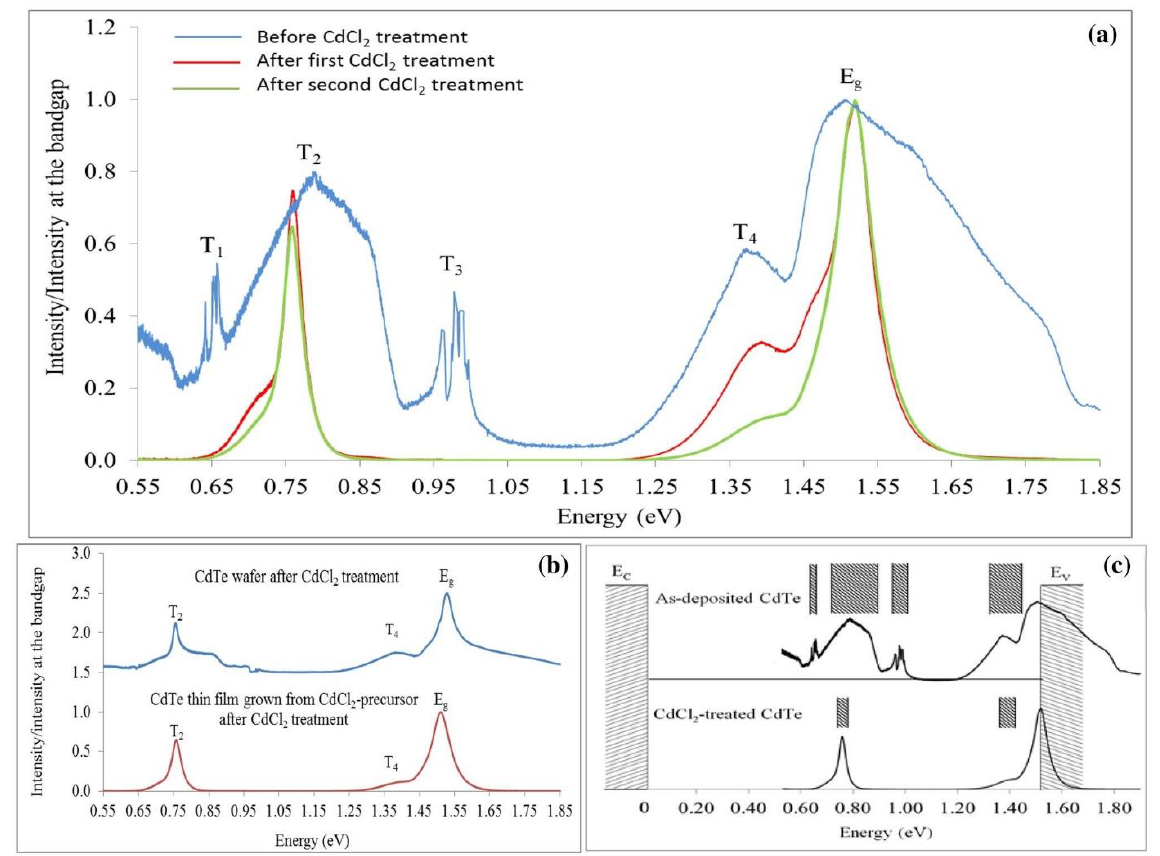
Figure 5. ( a ) PL spectra of as-deposited CdTe layers, grown from Cd-chloride precursor and the effects of subsequent CdCl 2 treatment in two steps [28]. ( b ) PL spectra of bulk CdTe wafers and electroplated CdTe after CdCl 2 treatment, and ( c ) the representation of defect distribution in as- deposited and CdCl 2 -treated CdTe thin films. Note the drastic removal of defects from the band gap of CdTe [28].